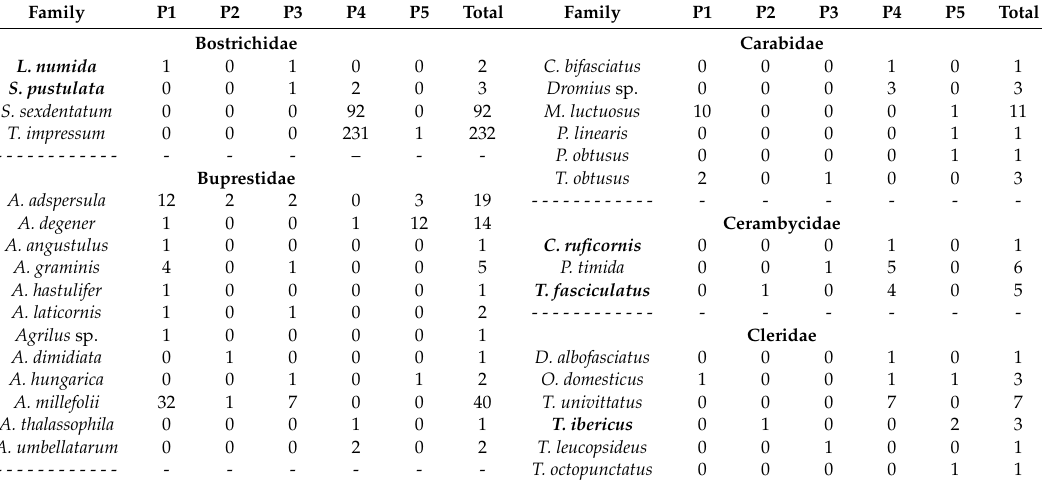
Table 3. Species of saproxylic beetles recorded, indicating for each of them the number of specimens, the sampling plot of provenance (P), and the family they belong to. In bold are the species included in red